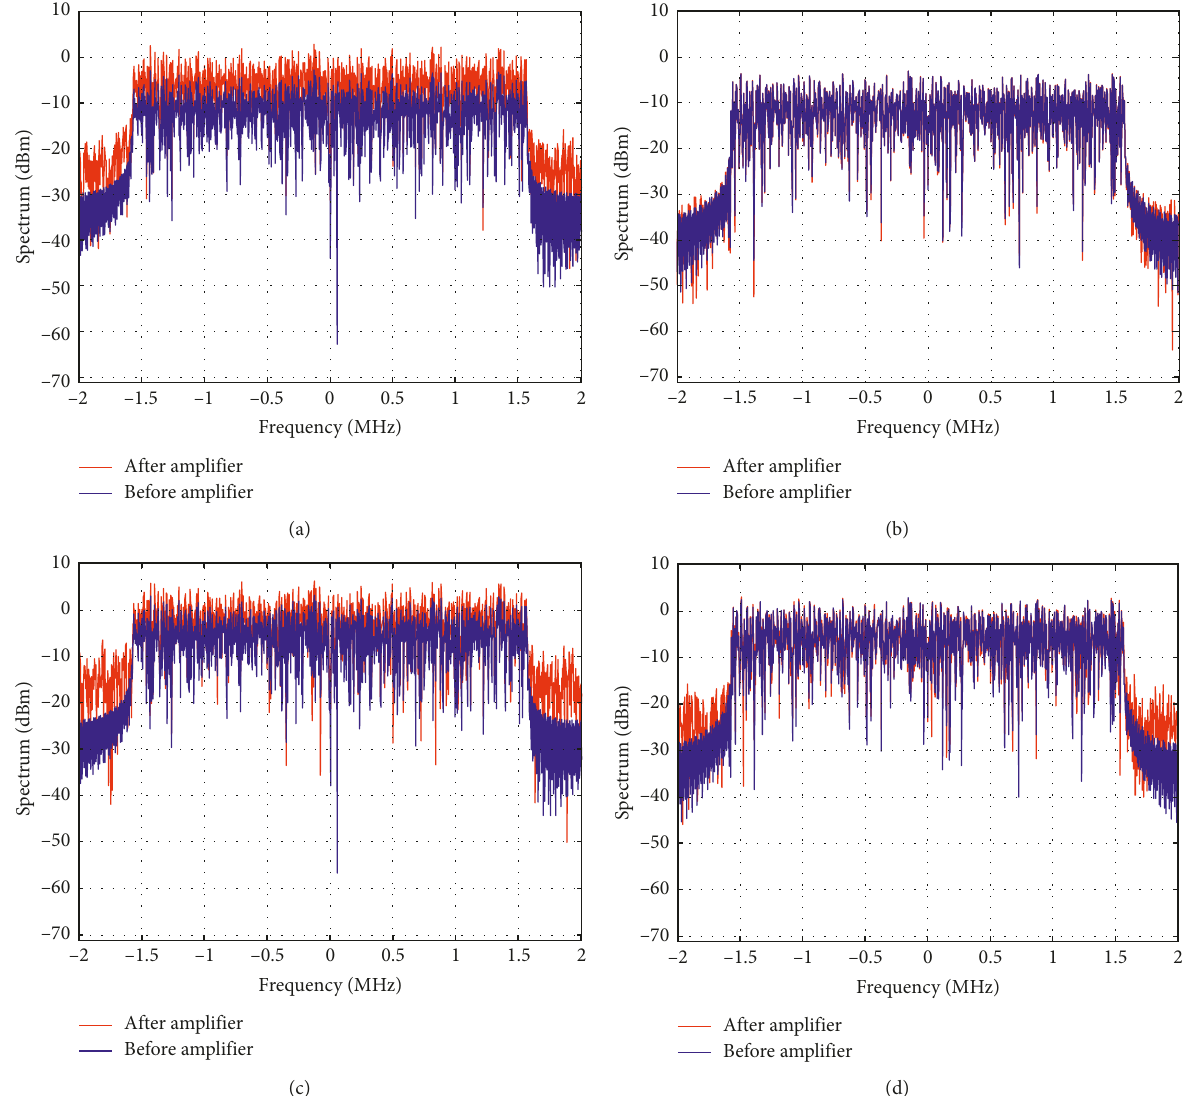
Figure 7: Power Spectral Density comparison performance of an OFDM signal without and with the proposed method. (a, b) 7dB from saturation point (moderate nonlinearity) and (c, d) 1 dB from saturation point (severe nonlinearity). (a) Without PTS-dynFWA-DPD, (b) with PTS-dynFWA-DPD, (c) without PTS-dynFWA-DPD, and (d) with